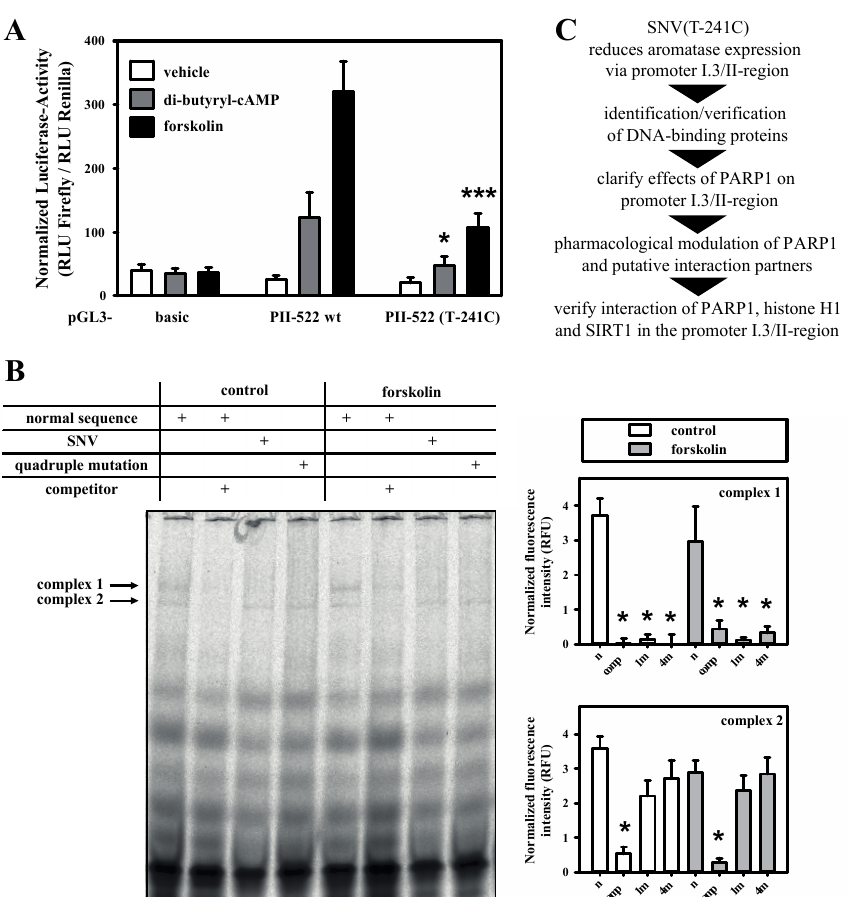
Figure 1. SNV(T-241C) reduces aromatase promoter I.3 / II activity and DNA–protein complex formation. ( A ) 3T3-L1 cells were co-transfected with Renilla luciferase pRL-SV40-plasmid for normalization and either pGL3-basic or aromatase promoter I.3 / II-containing pGL3-PII-522 wt or pGL3-PII-522 (T-241C) firefly luciferase reporter-plasmids. The cells were treated with vehicle, 1 mM di-butyryl-cAMP or 25 µM forskolin. The data are means of the three experiments done with triplicate replicates of each. Differences caused by SNV(T-241C) versus wild-type were analyzed with Students t-test ( n = 3; * p < 0.05; *** p < 0.001). ( B ) Soluble nuclear extracts from 3T3-L1 cells were used for electrophoretic mobility shift assays (EMSAs). Complex 1 formation was inhibited by competitor oligonucleotides (comp). SNV (1m)- or quadruple mutation (4m)-containing probes did not form complex 1, as seen with normal sequence probe (n). Complex 2 was solely inhibited by competitor ( n = 6; one representative experiment shown; * p < 0.05 for comparison with normal sequence probe only). ( C ) Flow chart highlighting subsequent steps of investigation (for a more detailed overview see Figure